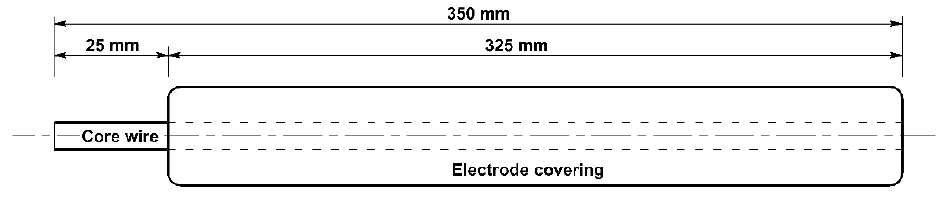
Figure 2. Scheme of the electrode with an indication of the lengths.